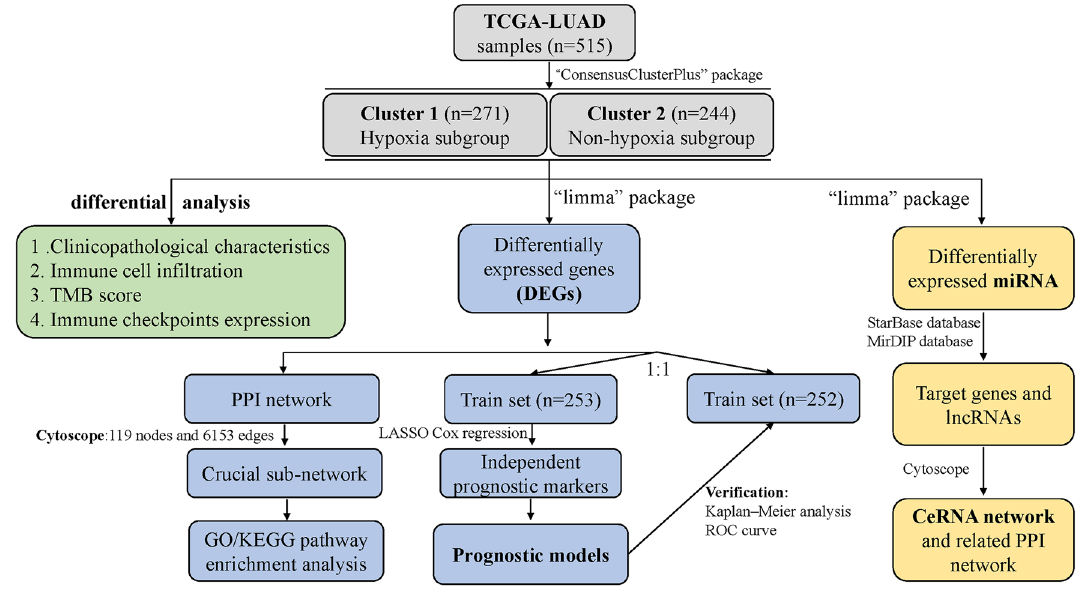
Figure 1. The flowchart of the analyzing